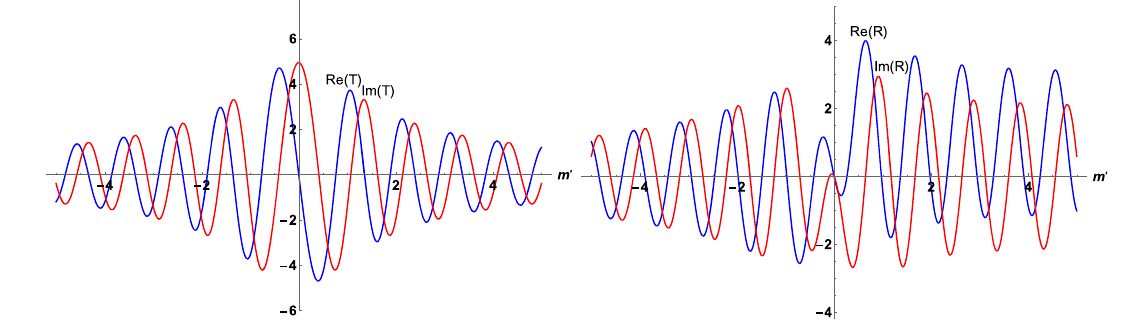
Fig. 5 The m (cid:2) -dependence of the transmission coefficient T and reflection coefficient R in the scattering with spin-flip scenario